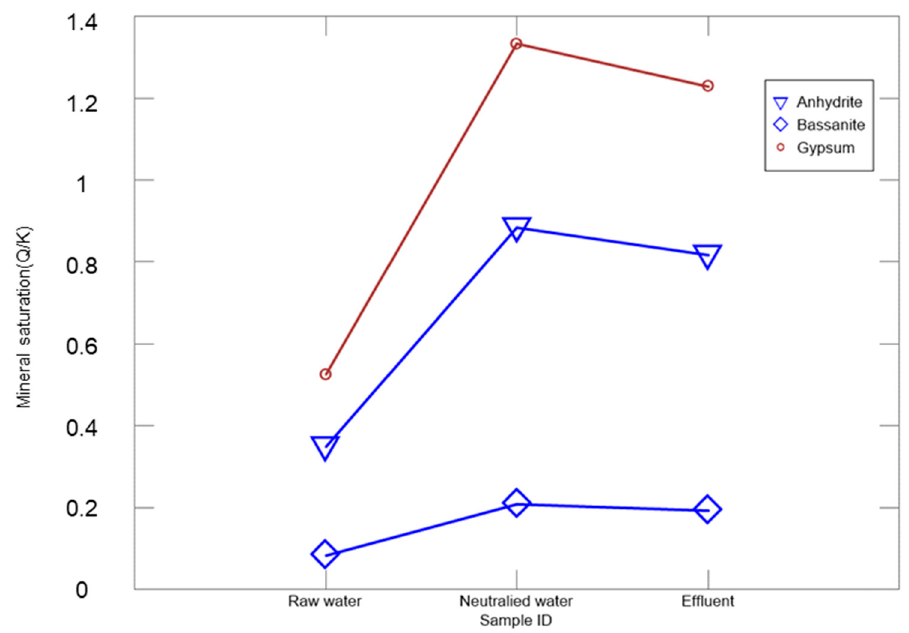
Figure 3. Comparison of mineral saturation at the three sampling points.